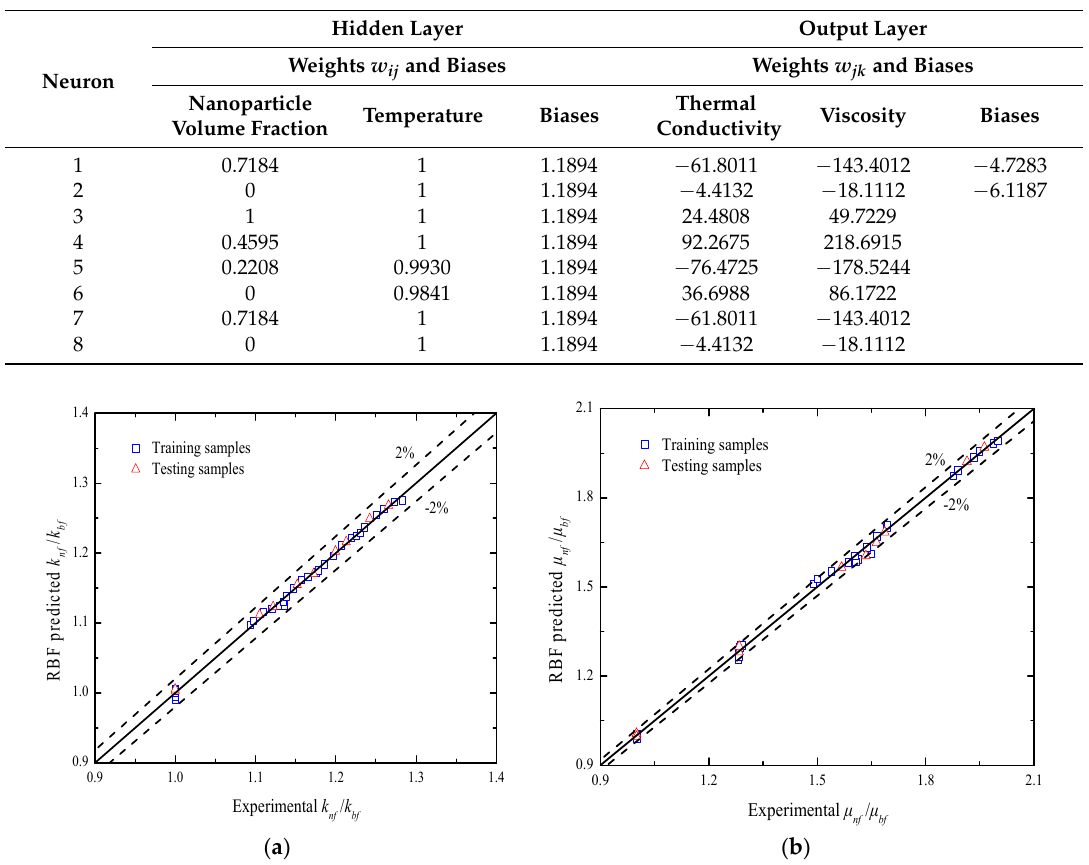
Table 4. Weight and bias coefficients of the developed RBF neural network.